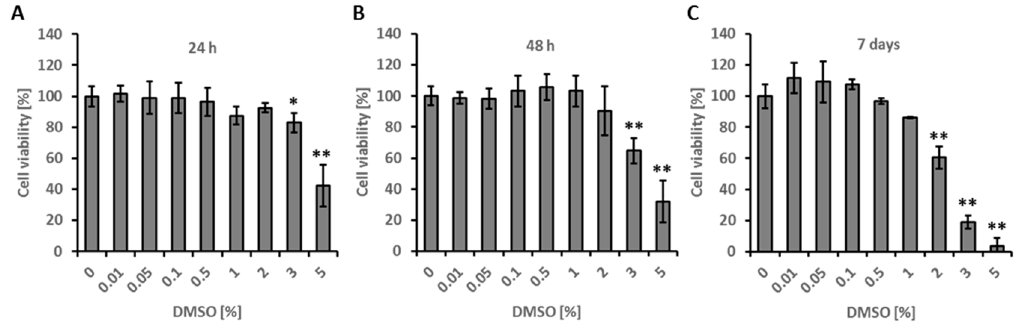
Figure 1. Cell viability following exposure to DMSO. Cells were grown in medium supplemented with increasing DMSO concentrations for 24 h ( A ), 48 h ( B ) or 7 days ( C ). Cell viability was assessed in MTT assay and was calculated as relative to control cells grown in culture medium without DMSO. Values represent means of at least two independent experiments (each run in triplicate) with bars representing standard deviation. Statistical significance was tested by one-way ANOVA followed by Tukey’s multiple comparison test; * p < 0.05 and ** p < 0.01 vs. control cells without DMSO treatment.